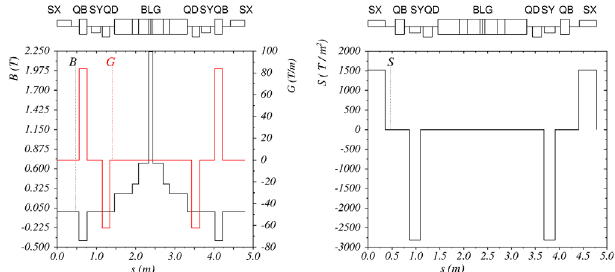
FIG. 27. Distribution of the dipole field (left, black), the gradient (left, red) and the sextupole gradient (right) in the cell with the longitudinal gradient dipole.